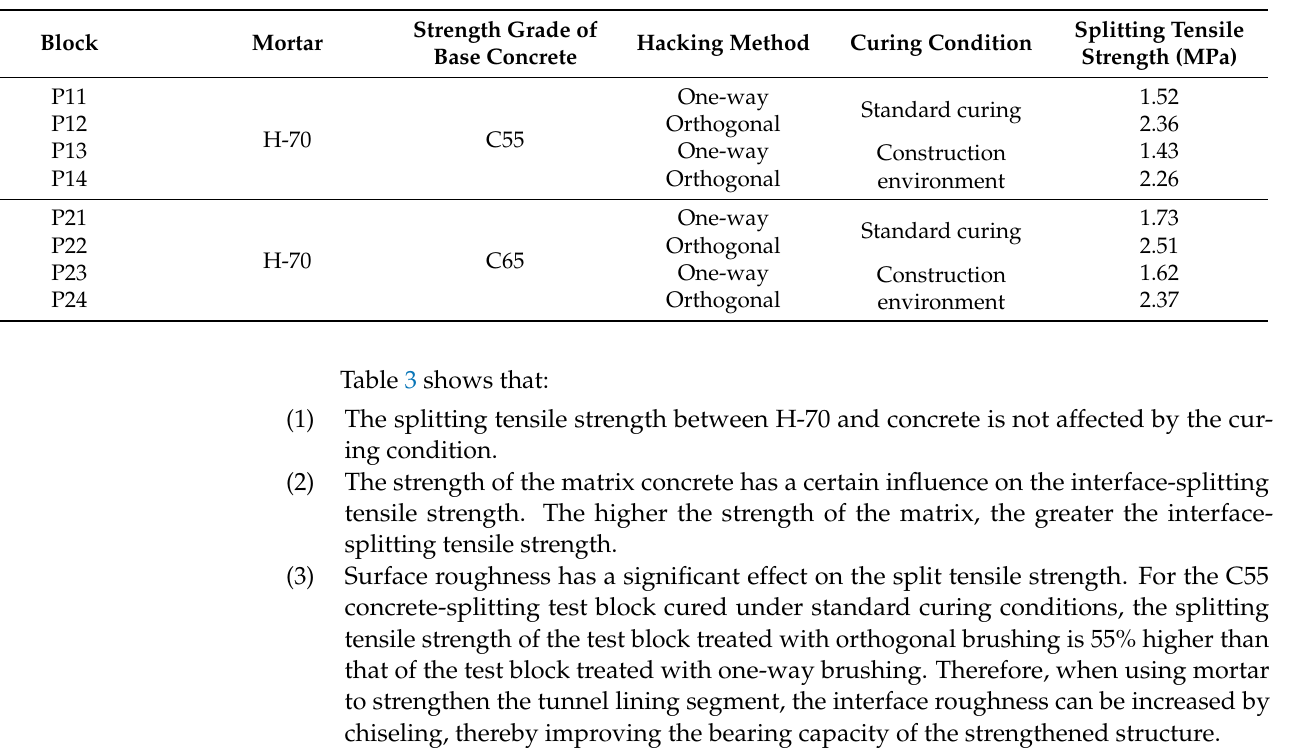
Table 3. Interface-splitting tensile strength.